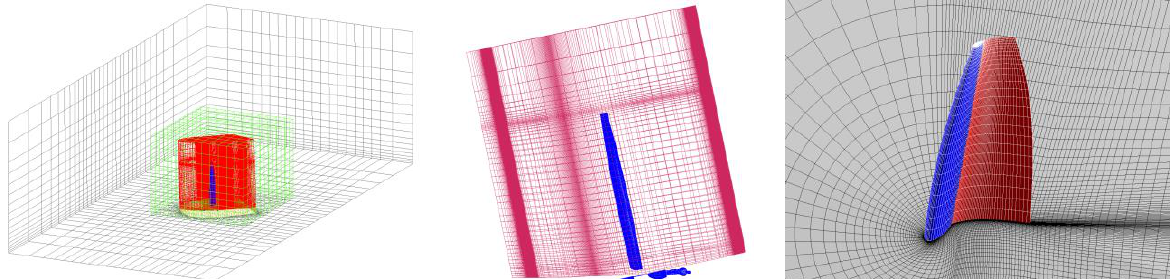
Figure 16. Detail of the parts of the computational domain.